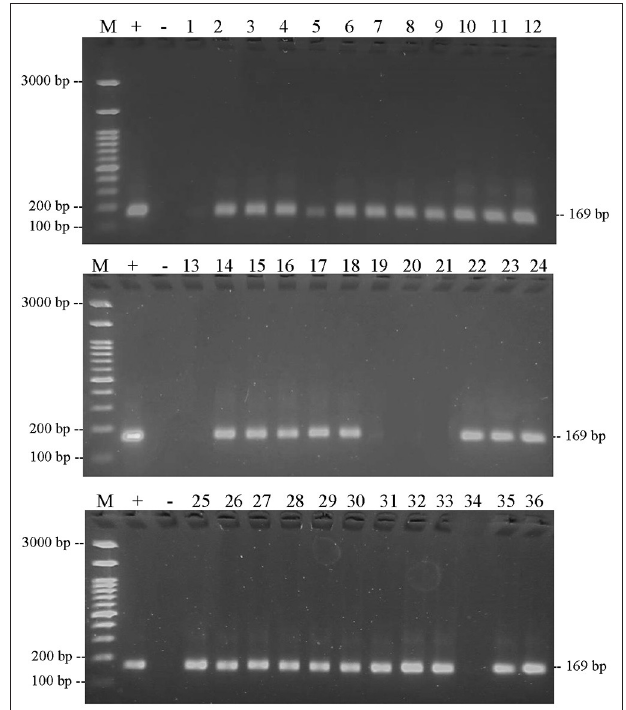
FIGURE 6 | Results of PCR amplification of meatball samples in Bojonegoro Regency with chicken primers electrophoresed on a 2% agarose gel. (M) DNA marker 100 bp; ( + ) positive control meatballs; (–) negative control (no template control); samples were coded with numbers